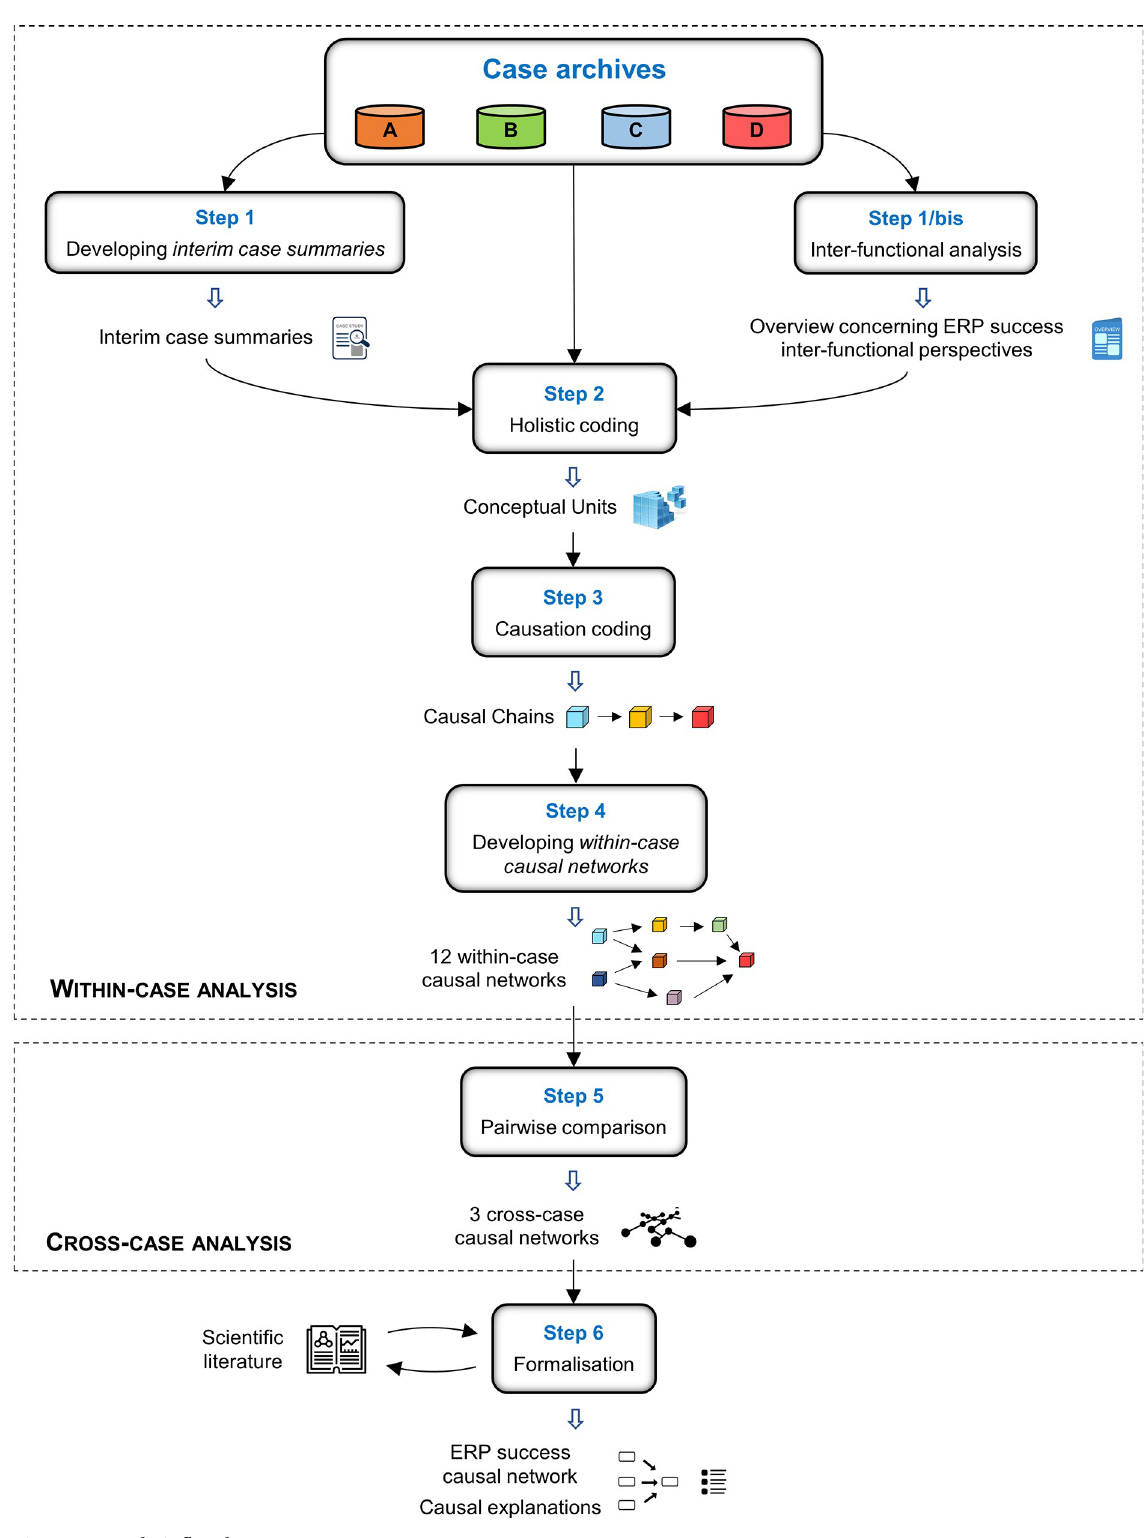
Fig 4. Data analysis